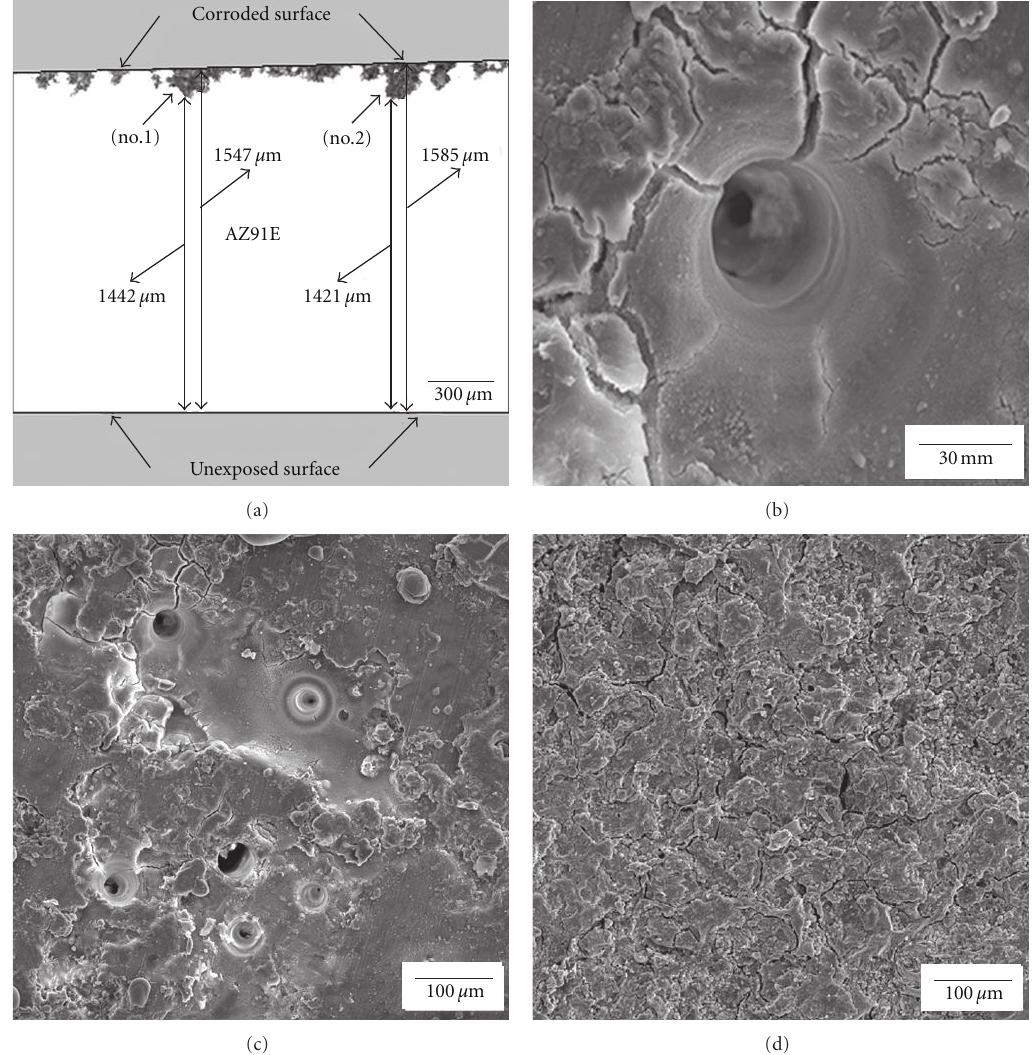
Figure 6: Micrographs of ((a) and (b)) optical pit depth and SEM pit shape on AZ91E surfaces, respectively, and ((c) and (d)) SEM corroded surfaces on AZ91D and ZA104, respectively, after 8 h of immersion in untreated 5% NaCl solution saturated with Mg(OH) 2 at pH 9 and 25 ◦